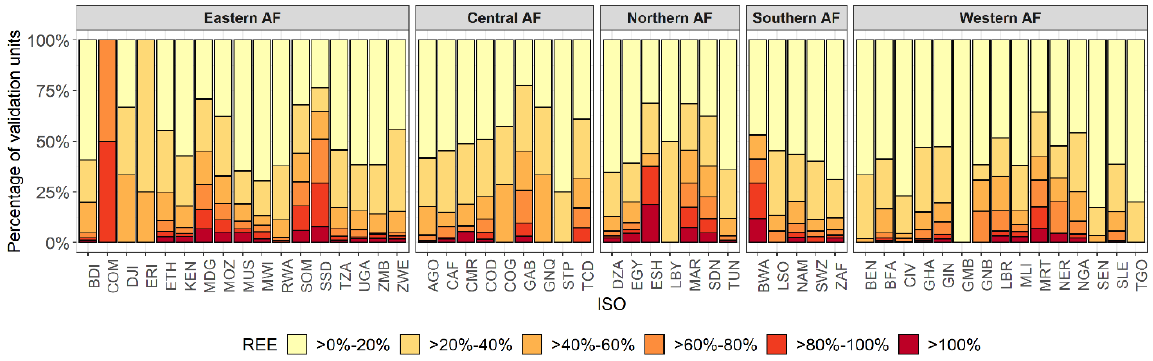
Figure 7. Stacked bar plots showing the percentage of validation units within each 20% Relative Estimation Error (REE) range.